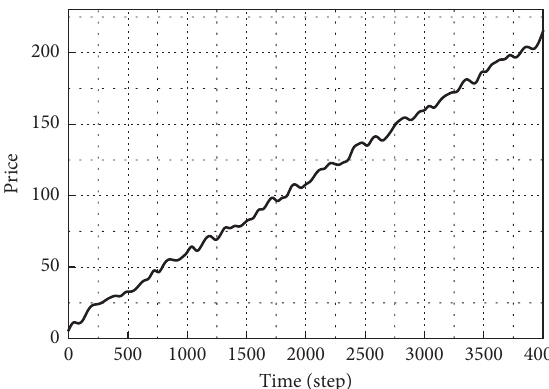
Figure 4: The trend of stock prices in the financial